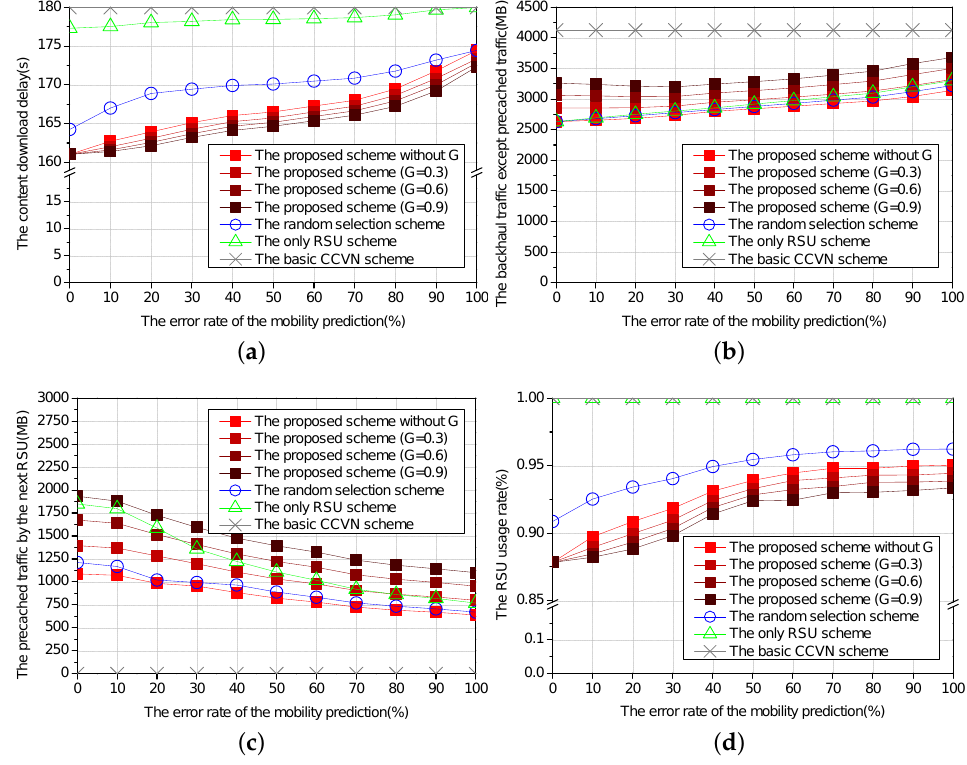
Figure 6. Simulation results for different error rates of the mobility predictions with various guard- bands: ( a ) the content download delay, ( b ) the backhaul traffic except precached traffic, ( c ) the precached traffic by next RSU and ( d ) the RSU usage rate.